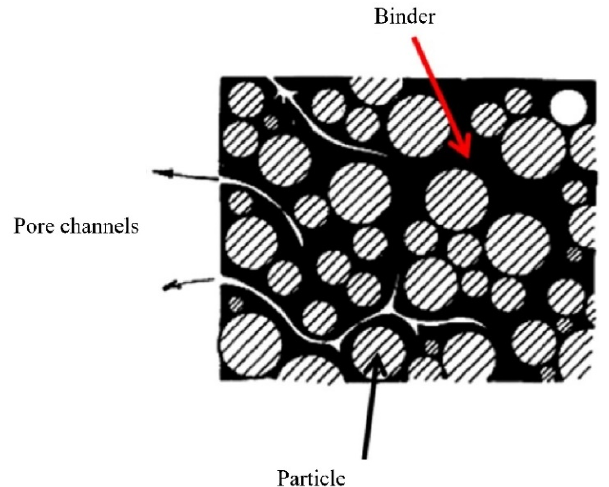
Figure 10. The schematic of binder distribution during the solvent debinding process. Reproduced with permission from reference [42], copyright © 2016 Elsevier B.V.